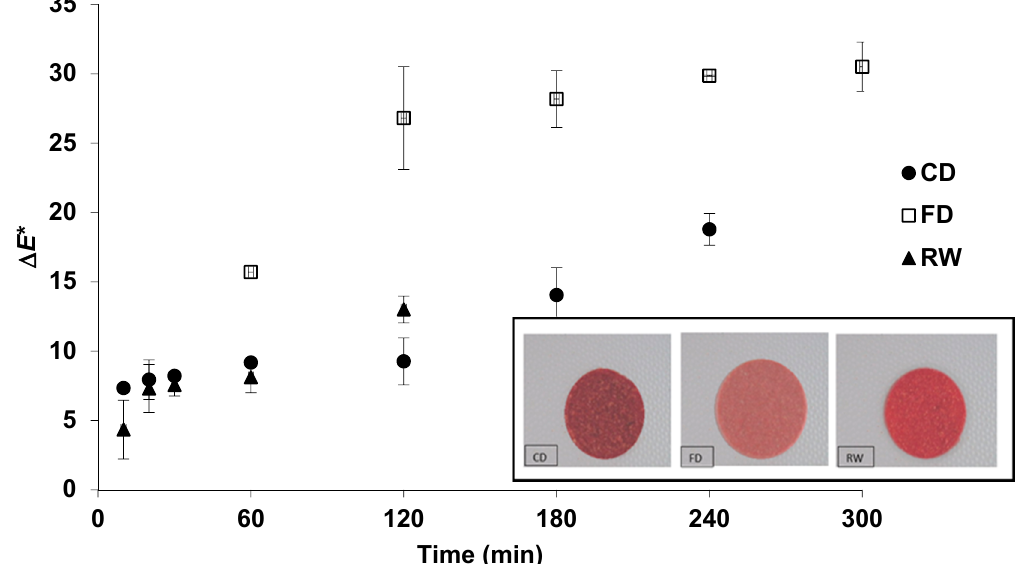
Figure 5. Total color change of guava samples using different drying methods (CD, FD and RW). Changes in the volume and porosity of guava samples at 4% (db) moisture are presented in